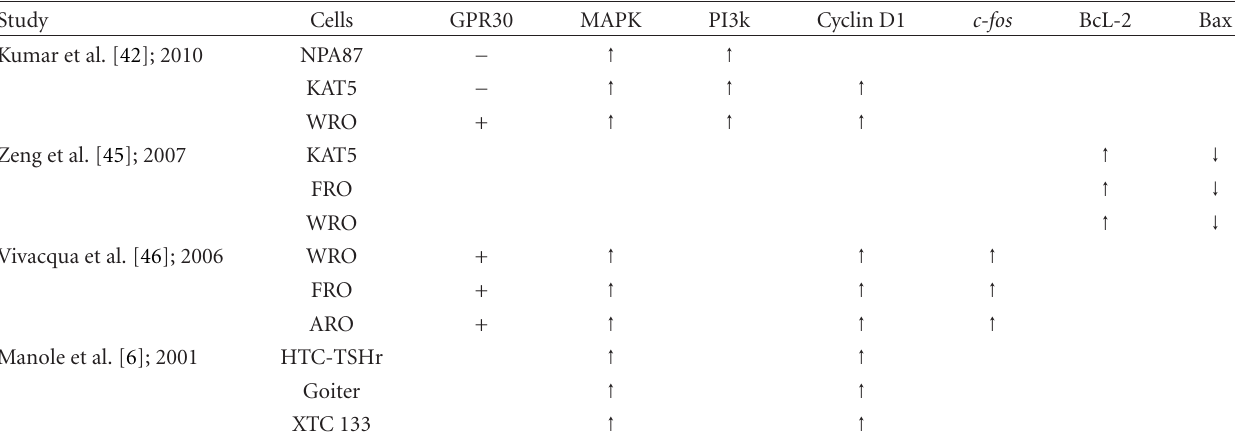
Table 4: Non-genomic estrogen e ff ects on thyroid